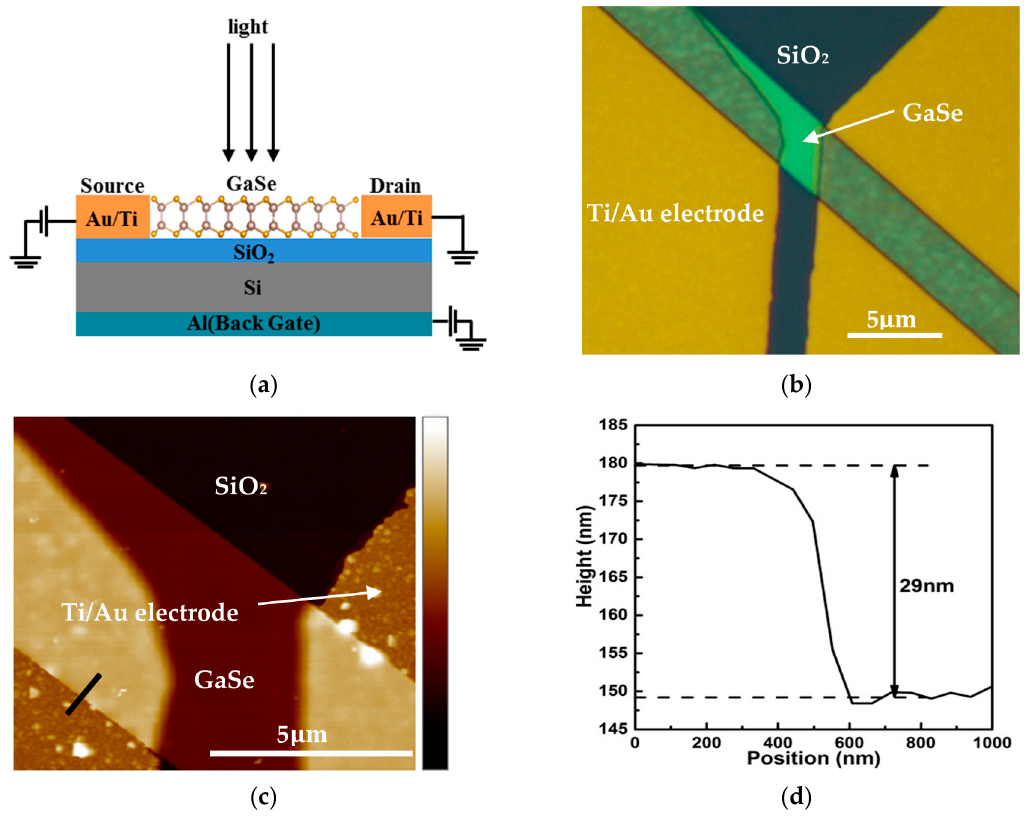
Figure 5. Few-layered GaSe photo-detector: ( a ) schematic diagram; ( b ) optical image; ( c ) AFM image; ( d ) AFM height profile along the black line.